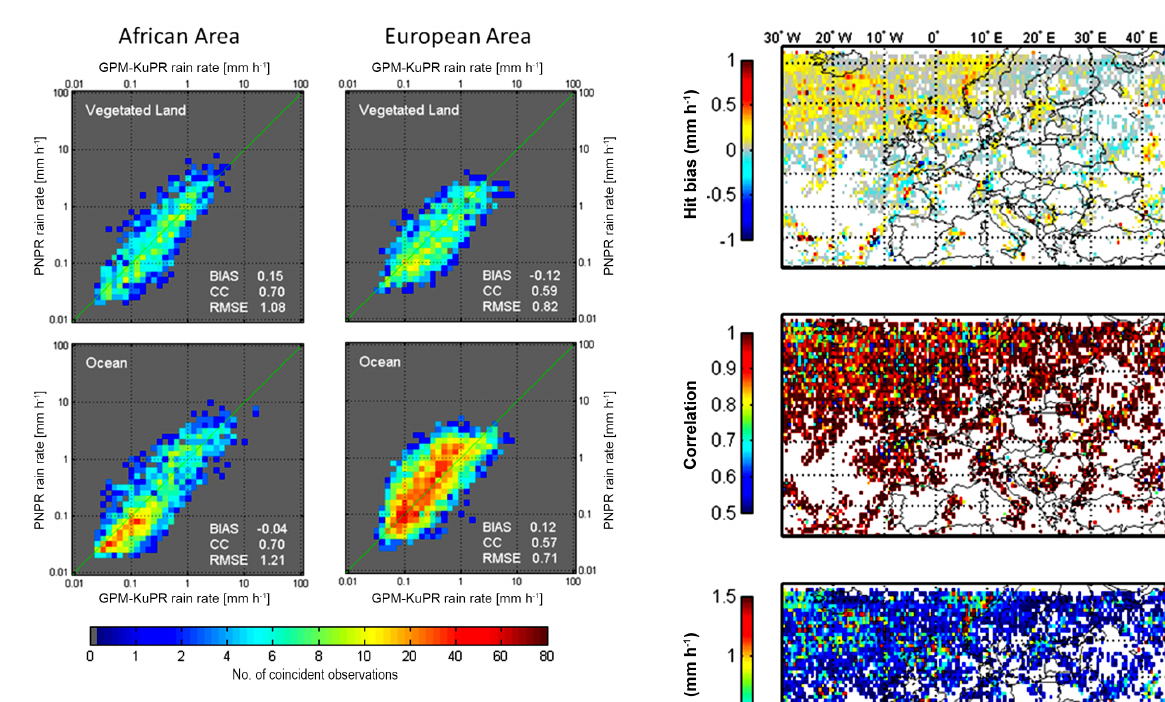
Figure 6. Density scatter plots of the PNPR v2 and GPM-KuPR mean rainfall rates (over a 0.5 ◦ × 0.5 ◦ regular grid, for the period 1 March 2014–31 May 2015) for the African area (left panels) and the European area (right panels), for vegetated land and ocean. A logarithmic scale is used for the precipitation rates in mmh − 1 .